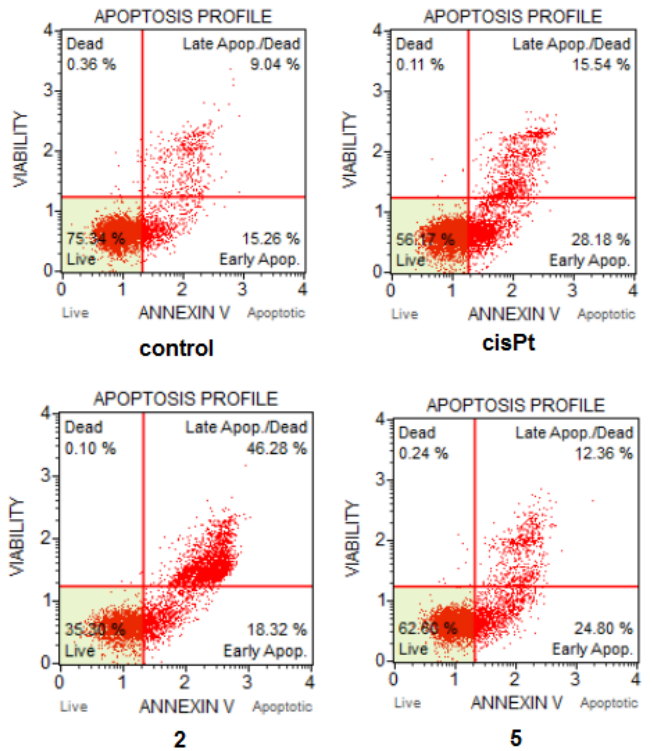
Figure 6. HCT-116 apoptotic profile after treatment with cisplatin and compounds 2 , 5 after 48 h. Concentration of compounds 2 ∙ IC 50 ( μ M).